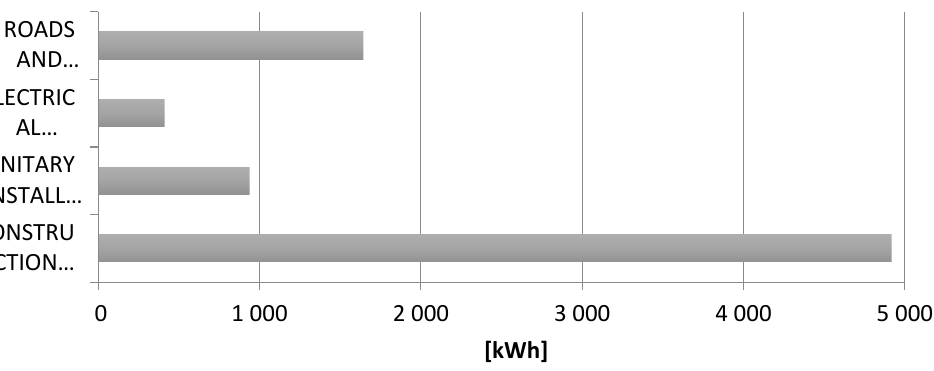
Figure 5. Human workload during the construction of the research object converted into energy consumption [own study based on the investor’s data].